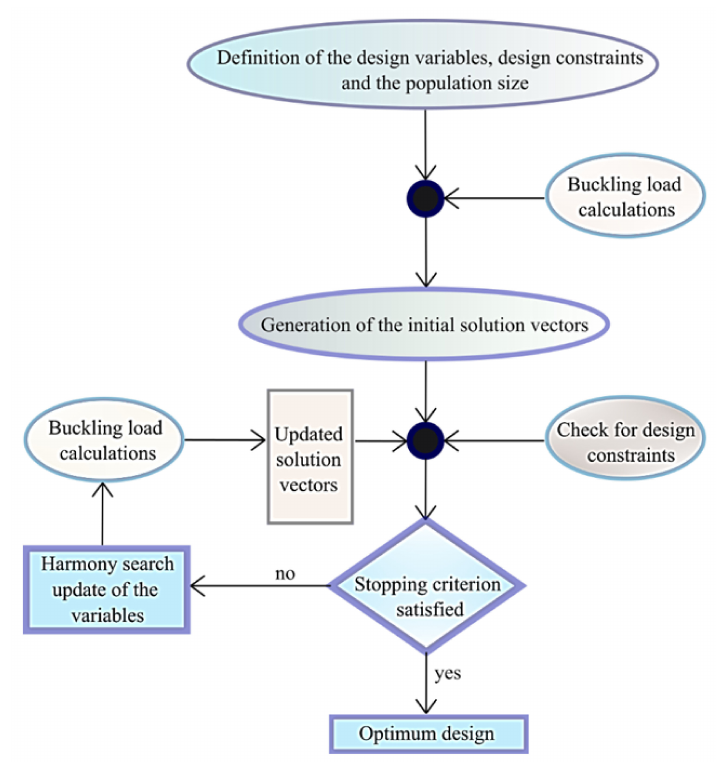
Figure 1. Harmony search optimization